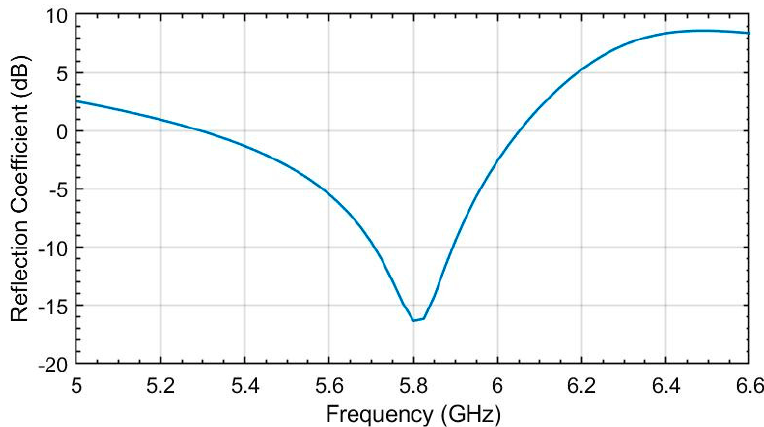
Figure 8. Simulated reflection coefficient evaluated with respect to the optimal impedance (cid:1852) (cid:3042)(cid:3043)(cid:3047) .